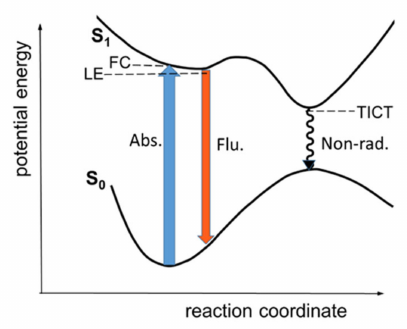
Figure 2. Schematic one-dimensional S 0 and S 1 state potential energy curves for PhSt.